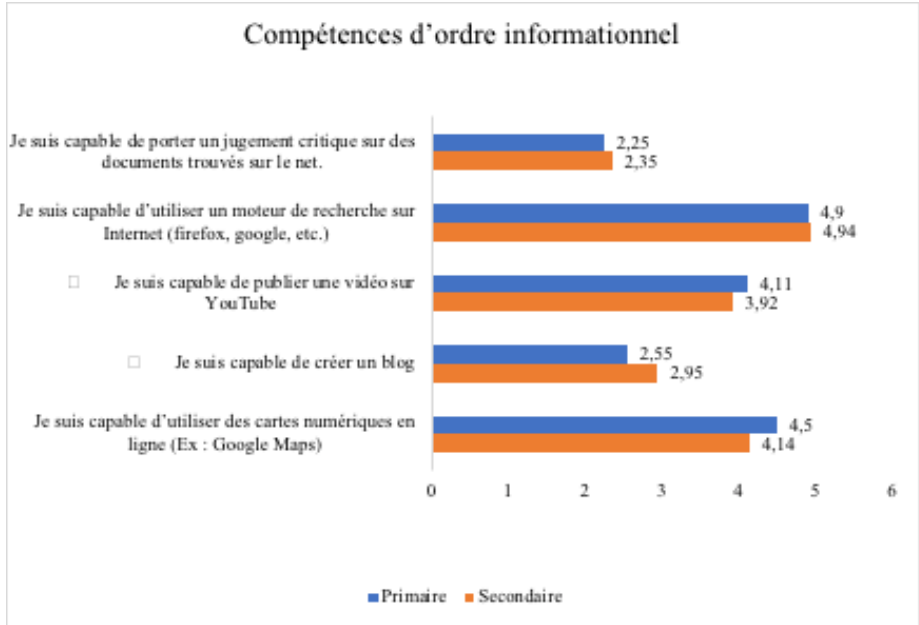
Fig.9. Les compétences d’ordre informationnel déclarées maitrisées à l’issu de la formation au